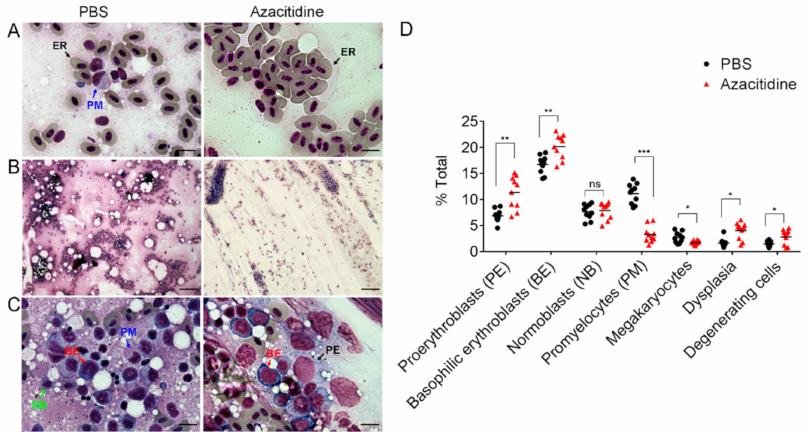
Figure 2. Marked suppression of myeloid series in WKM of zebrafish treated with azacitidine. Liu’s stained micrographs of PBS- and azacitidine-treated peripheral blood ( A ) and kidney marrow smears ( B , C ). Quantifications of indicated subpopulations are shown in ( D ); each dot in the plot represents the average of relative cell counts under 10 high-power fields for one WKM smear; n = 10 for each group. ER, erythrocyte; * p < 0.05, ** p < 0.01, *** p < 0.001, ns, not significant, by the Mann–Whitney U test. Scale bars in ( A ) and ( C ), 10 µ m; scale bar in ( B ), 100 µ